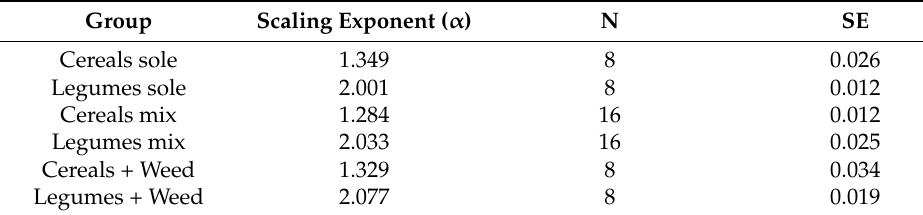
Table 2. Scaling exponents ( α ) for cereals and legumes grown as sole crops and in mixtures, with and without the weed C. album , based on the nutrient volumes for N and P (VNP) vs. the volumes of other nutrients (VOth; K, Ca, Mg and S). The scaling exponents were based on data from the flowering stage.